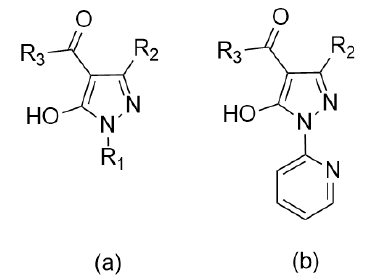
Figure 3. Structure of 4-acylpyrazolones: the placement of 2-pyridyl group in R 1 position of 4-acylpyrazolones ( a ) introduces a further N , N -binding site ( b ).